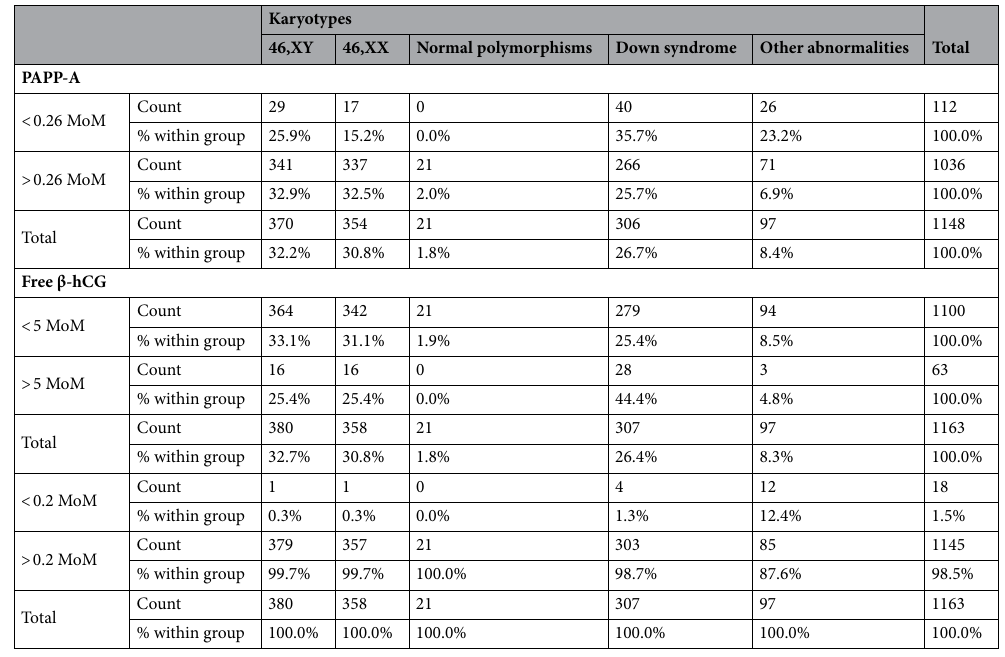
Table 9. Association between PAPP-A and free β-hCG levels and chromosomal abnormalities.